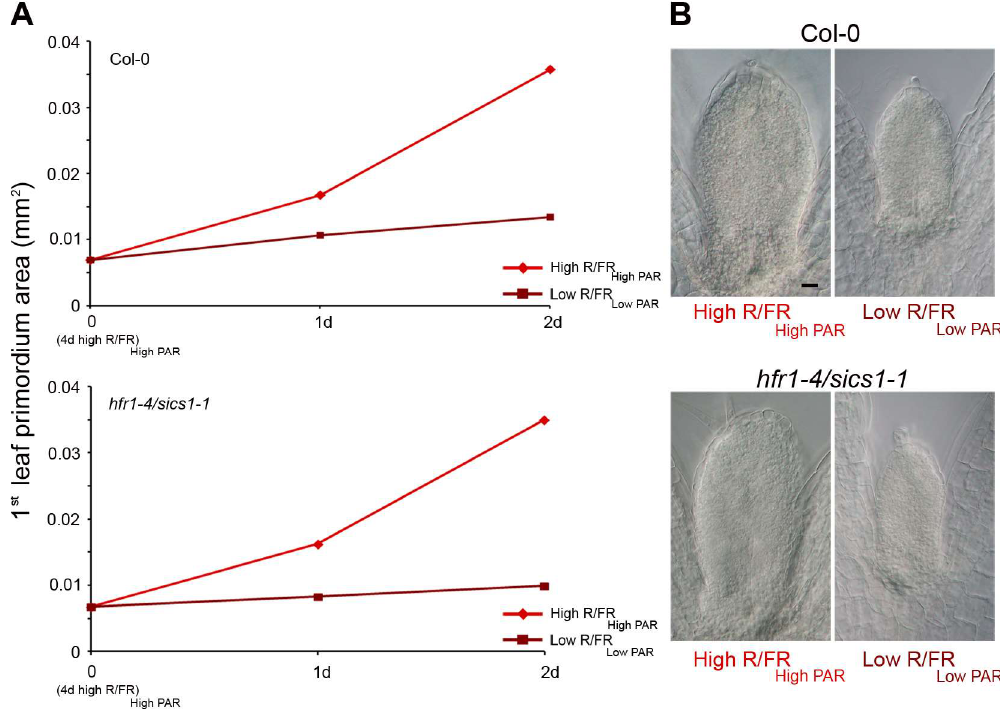
Figure 4. hfr1/sics1 mutation causes an exaggerated leaf primordium phenotype in shade. (A) hfr1/sics1 and control (Col-0) seedlings were grown for four days in high R/FR High PAR , and then either maintained in the same light regime (red lines) or transferred to low R/FR Low PAR for different times (garnet red lines). The mean area of the first/second leaf primordium was calculated by analyzing 50 samples in each condition. ( B ) Leaf primordia, observed under Differential Interference Contrast (DIC) optics, of hfr1/sics1 and Col-0 grown for four days in high R/FR High PAR , and then either maintained in the same light regime or transferred for two days to low R/FR Low PAR . Light outputs were as previously reported [9]. Scale bar, 10 μm.